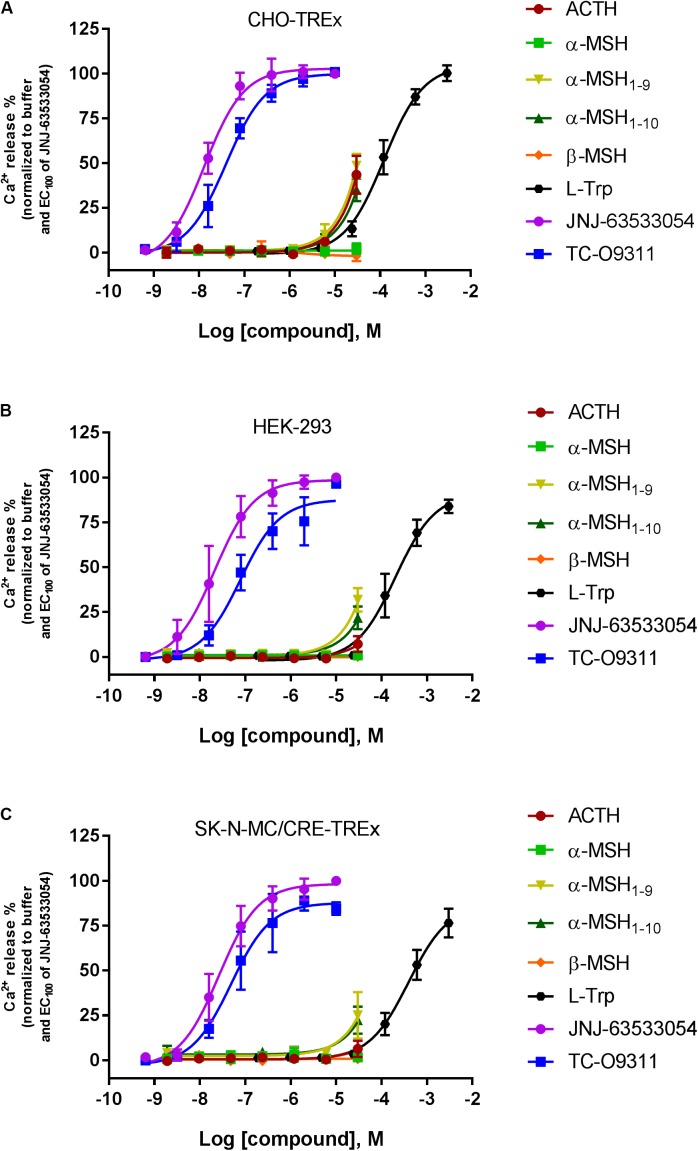
Concentration response of the MC agonists ACTH, α-MSH, β-MSH, and GPR139 agonists (L-Trp, JNJ-63533054, and TC-O9311) on calcium mobilization in three different host cells stably expressing human GPR139: (A) CHO-TREx, (B) HEK-293, and (C) SK-N-MC/CRE-TREx. Data are the mean ± SEM of at least three separate experiments performed in duplicates.